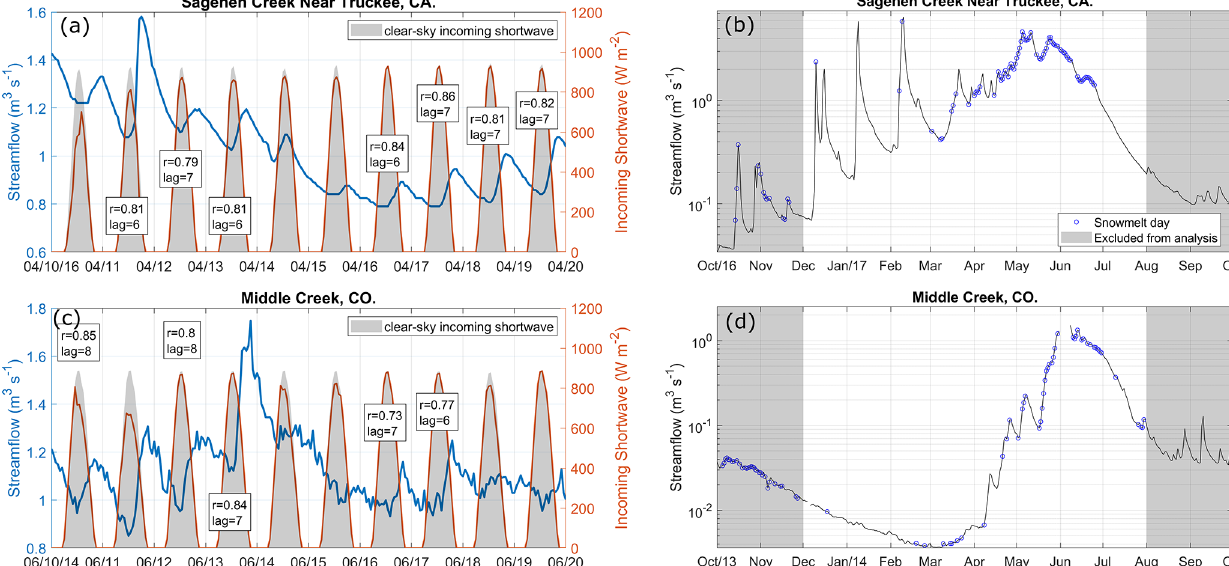
Figure 1. Examples of the diel cycle analysis applied to two watersheds located in (a, b) California (WY2016) and (c, d) Colorado (WY2014). Panels (a) and (c) show hourly solar radiation (orange) and streamflow (blue). The first statistically significant ( p < 0 . 01) lagged Spearman correlation ( r > 0 . 6) between streamflow and solar radiation is shown in a text box for clear-sky days only ( > 80% of clear-sky solar radiation). Panels (b) and (d) show the solar radiation-driven snowmelt days (blue circles) on top of the annual hydrograph (semi-log scale) for the period of analysis (white background; December to